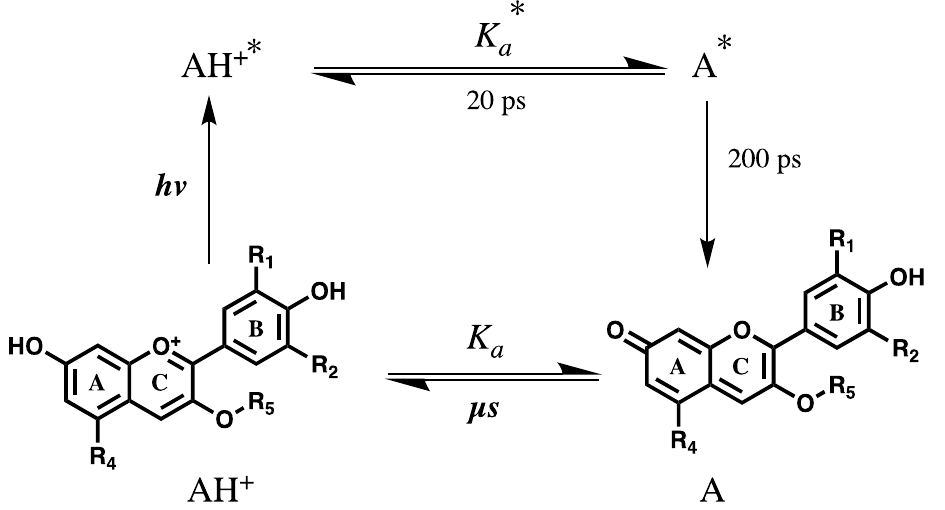
Figure 3. Ground- and excited-state proton transfer process of anthocyanins. Absorption of light (h ν ) by the ground state cation form (AH + ) produces the first excited singlet state of the cation (AH + *) , which transfers a proton to water to form the excited singlet state of the conjugate base A*. The excited base form (A*) lives about 200 ps before transforming the excitation energy into heat and returning to the ground state of the base (A), which then reprotonates back to AH + with no net chemistry. R 1 = H, OH or OCH 3 ; R 2 = H, OH or OCH 3 ; R 4 = OH or sugar moiety; R 5 = sugar moiety. The sugar moiety